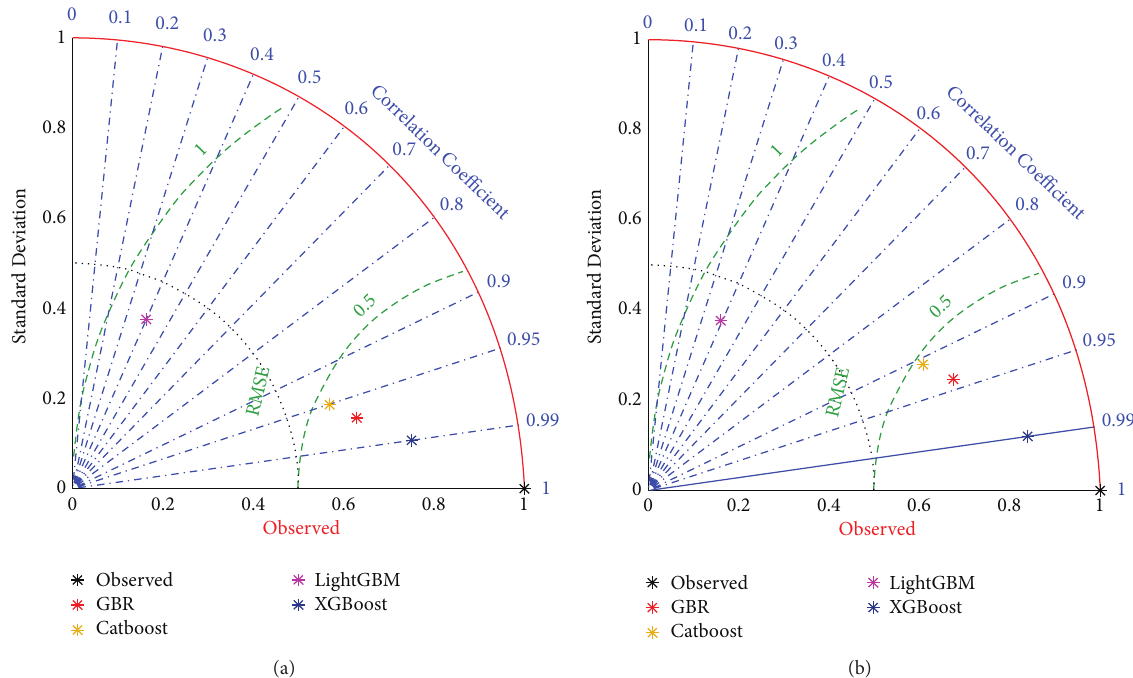
Figure 14: Taylor diagrammatic representation of GBR, XGBoost, Catboost, and LightGBM models in the (a) training phase and (b) testing phase.